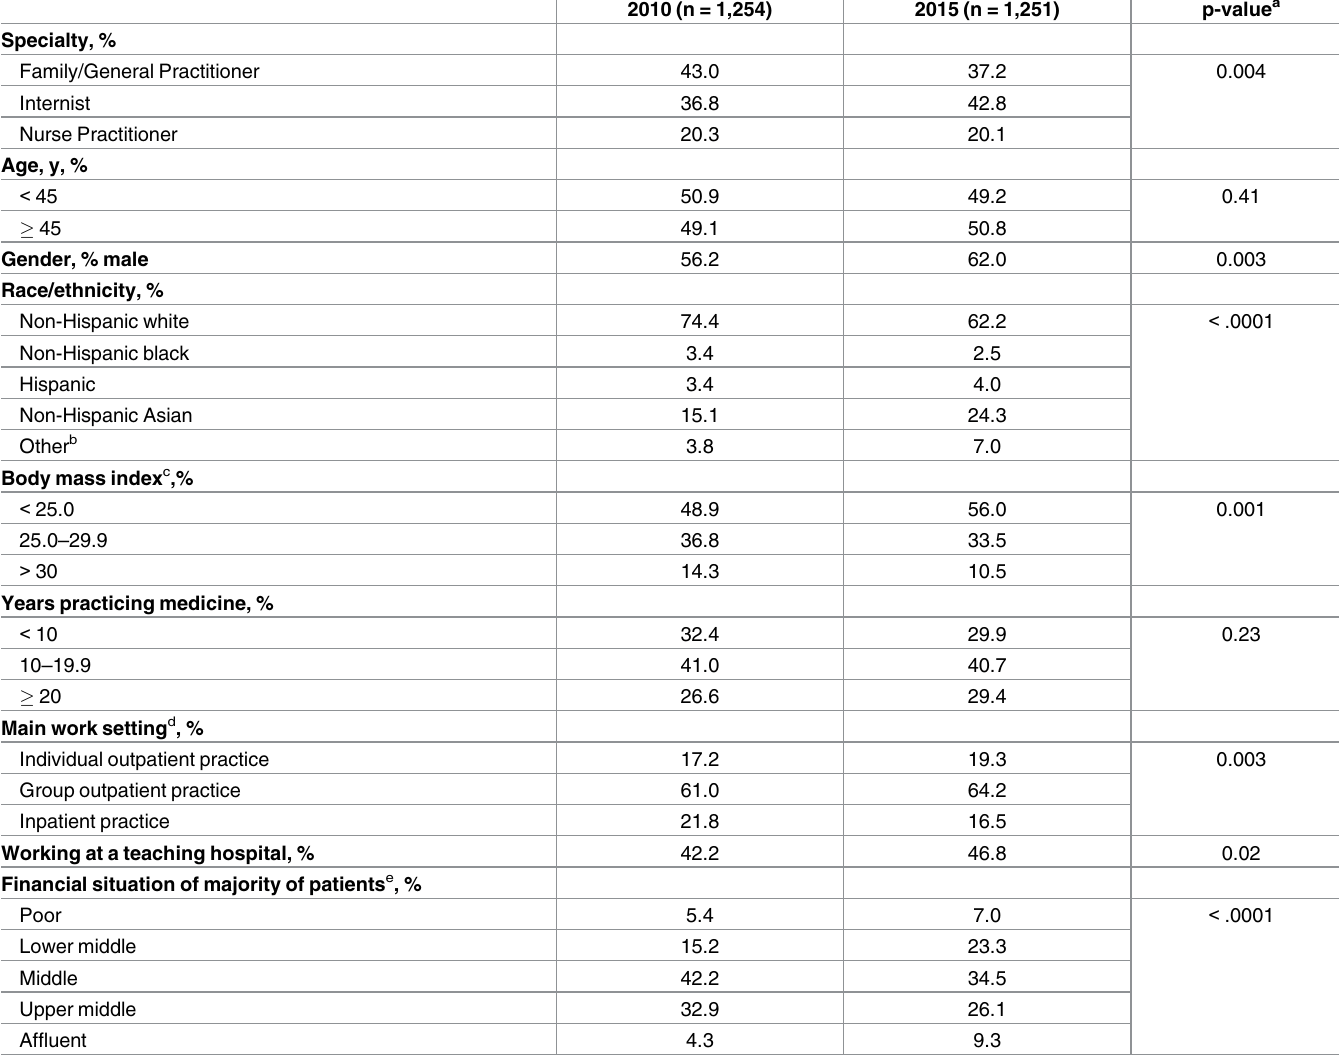
Table 2. Demographic, health, and practice characteristics of primary healthcare providers, DocStyles 2010 and